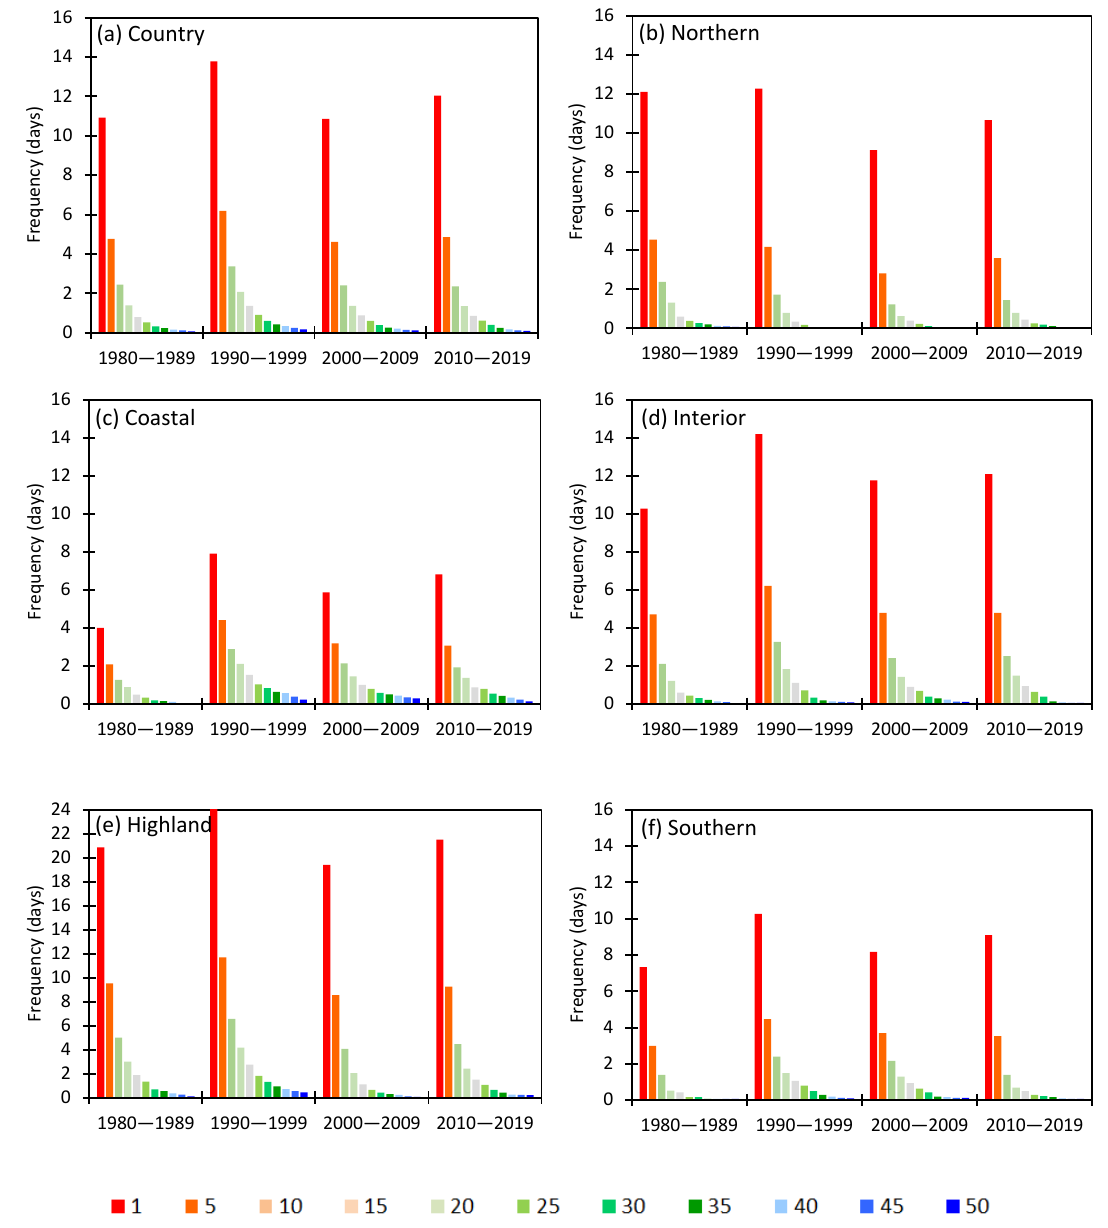
Figure 11. Annual frequency (days) of rainfall extremes in different decades for ( a ) country average, ( b ) northern, ( c ) coastal, ( d ) interior, ( e ) highland, and ( f ) southern regions in Saudi Arabia. The vertical scale for all panels is the same except for the highland.